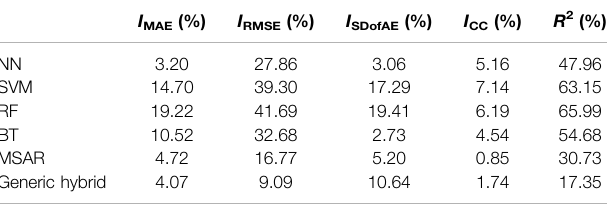
TABLE 2 | Improvement coef fi cients of the proposed method vs. S 1 , S 2 , and S 3 I MAE (%) Proposed vs. S 1